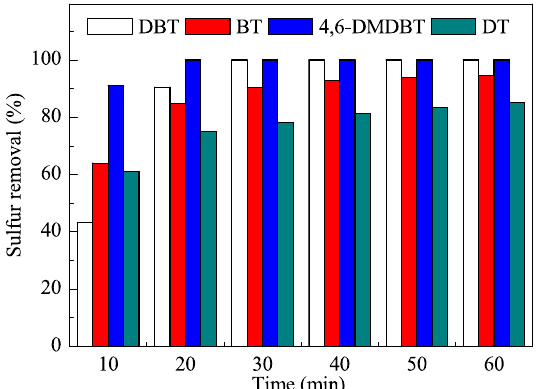
Figure 11. Removal of sulfur compounds in oxidative desulfurization (ODS) with the W ‐ SiO 2 ‐ 20 catalyst. DBT: dibenzothiophene; BT: benzothiophene; 4,6 ‐ DMDBT: 4,6 ‐ dimethyldibenzothiophene;